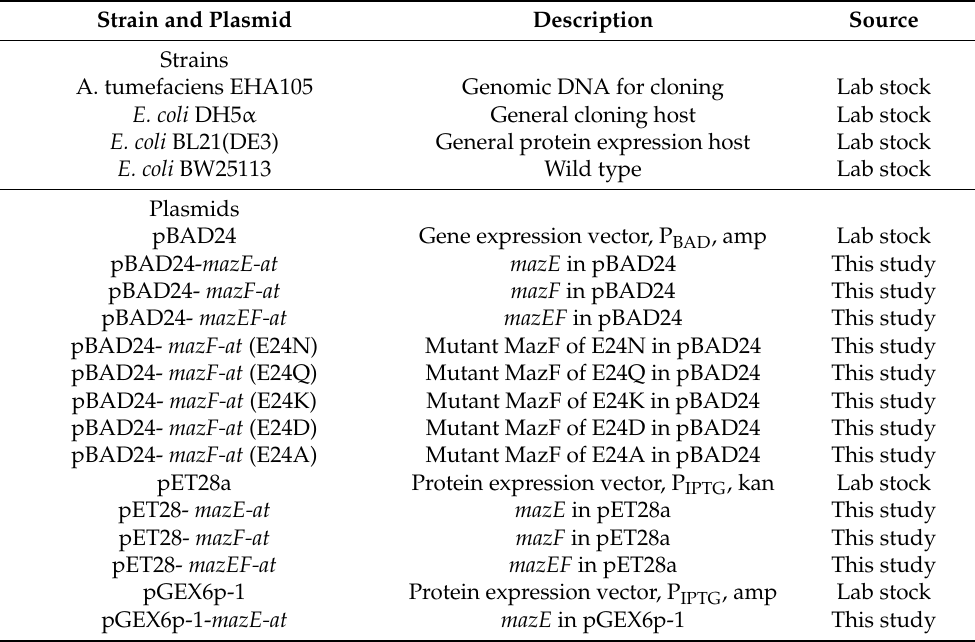
Table 1. Strains and plasmids used in this